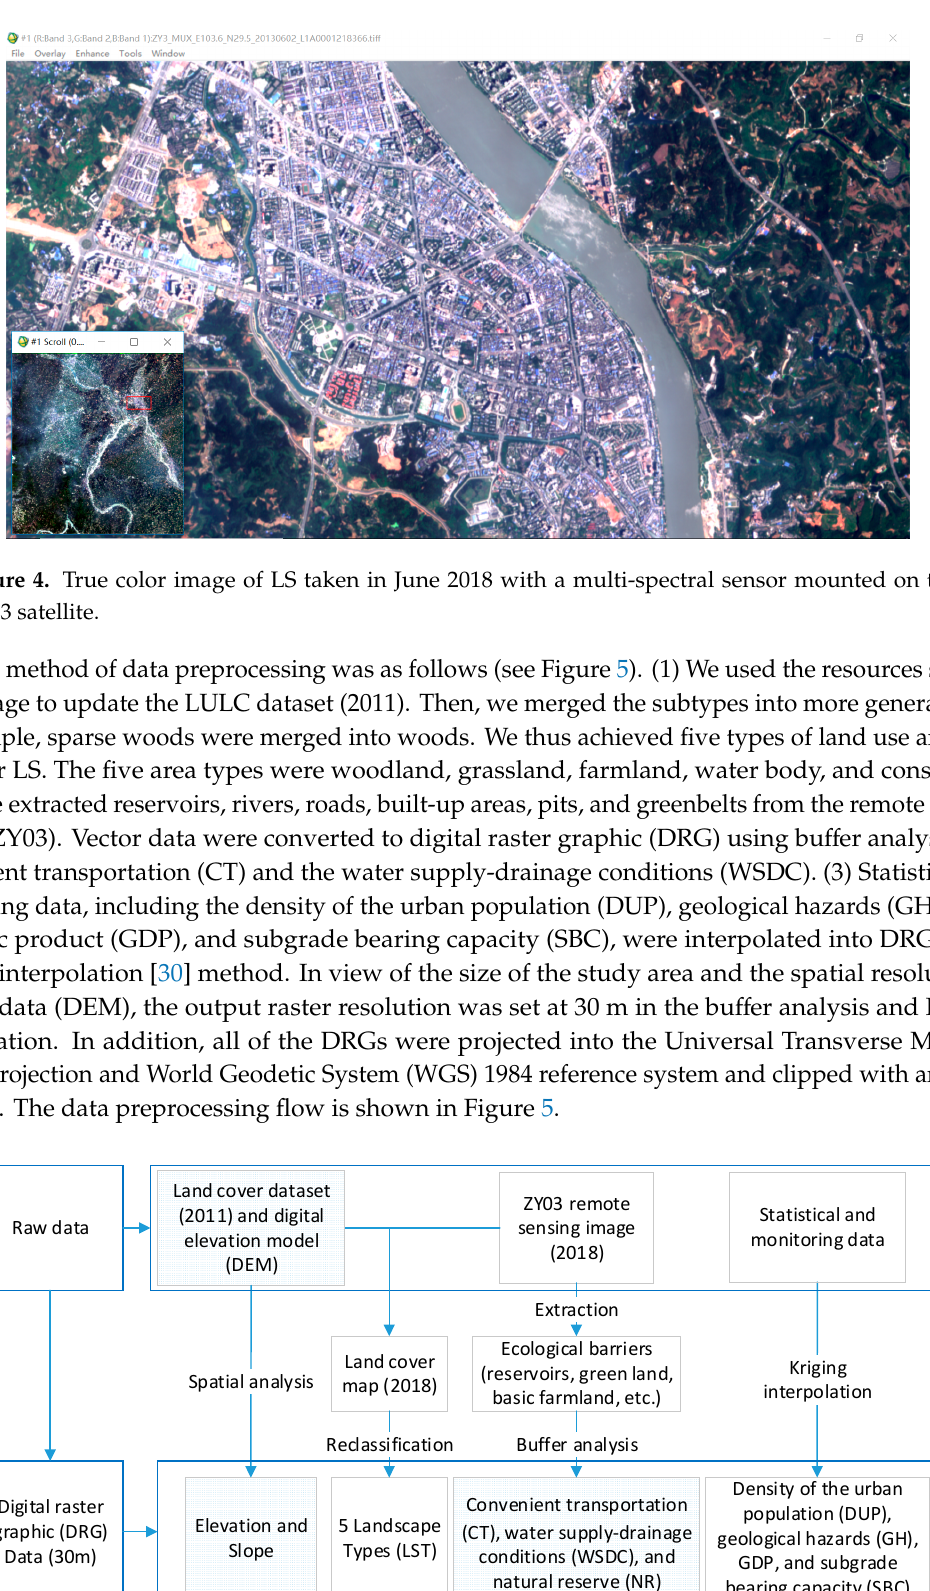
Figure 5. Flow chart of data preprocessing.